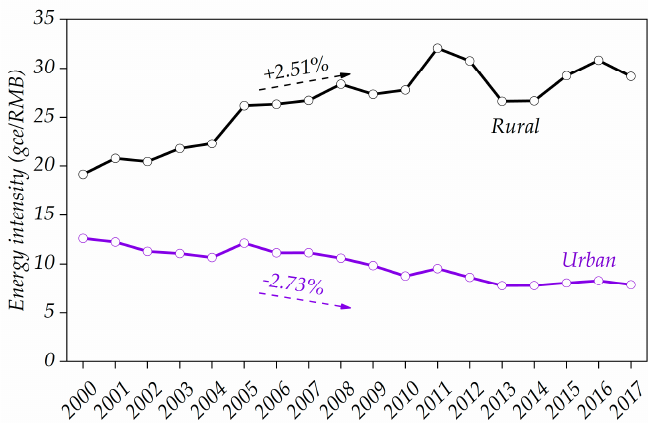
Figure 4. Trends of energy intensity in urban and rural Guangdong during 2000–2017.